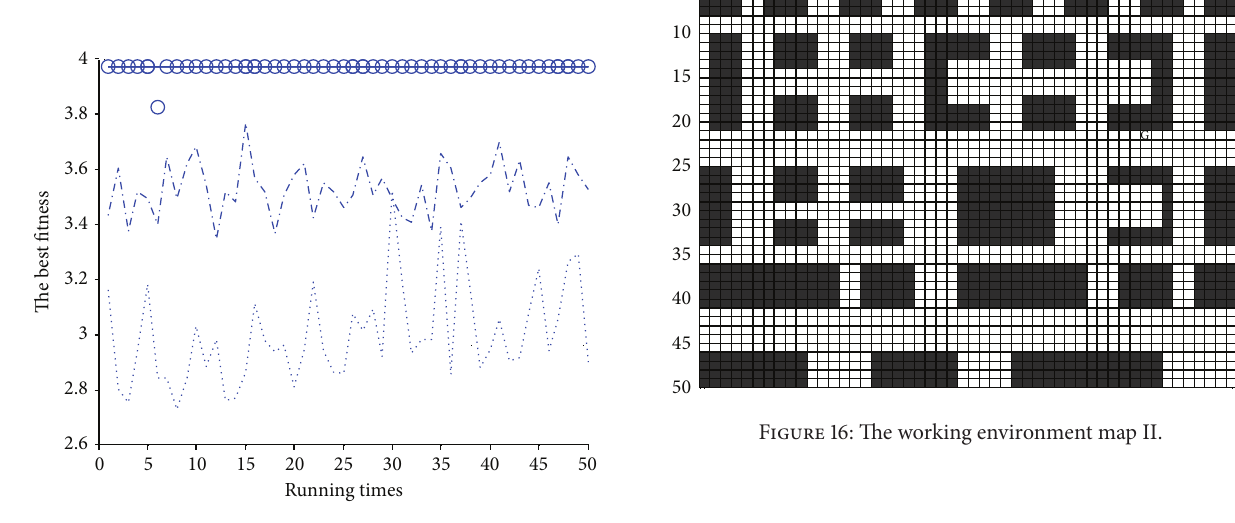
Figure 13: Convergence curves about the optimal fitness on map I.